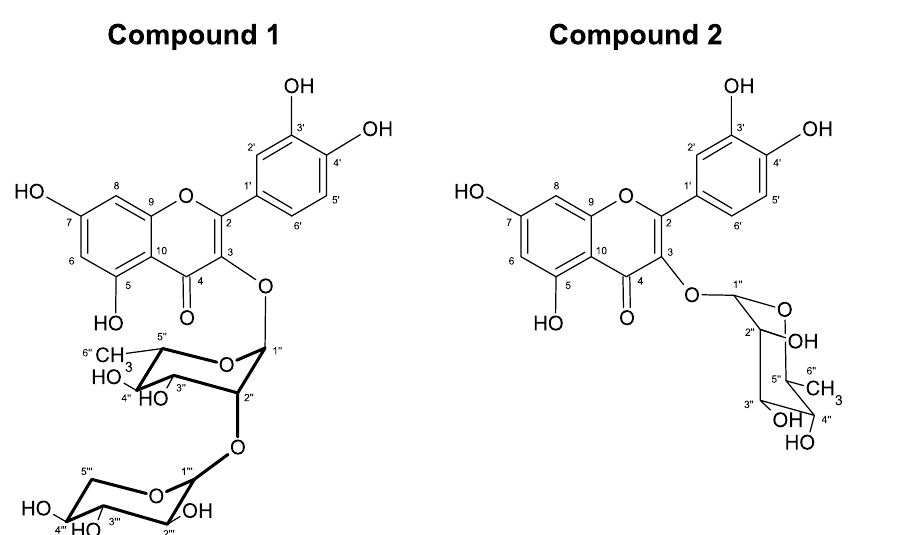
FIGURE 4 - Structural formulas of compound 1 quercetin 3-O-α-L-arabinopyranosyl-(1→2)-α-L-rhamnopyranoside and compound 2 quercitrin isolated from the Kalanchoe pinnata